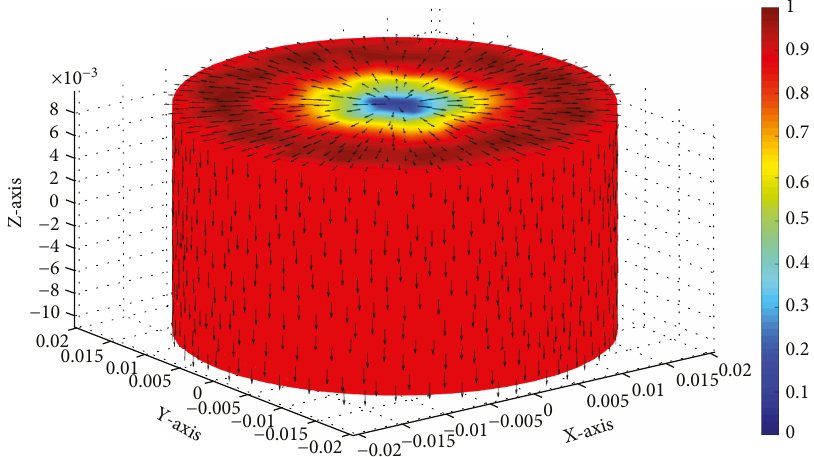
Figure 12: The distribution of the modal current corresponding to the only nonradiative CM at 5.75GHz.